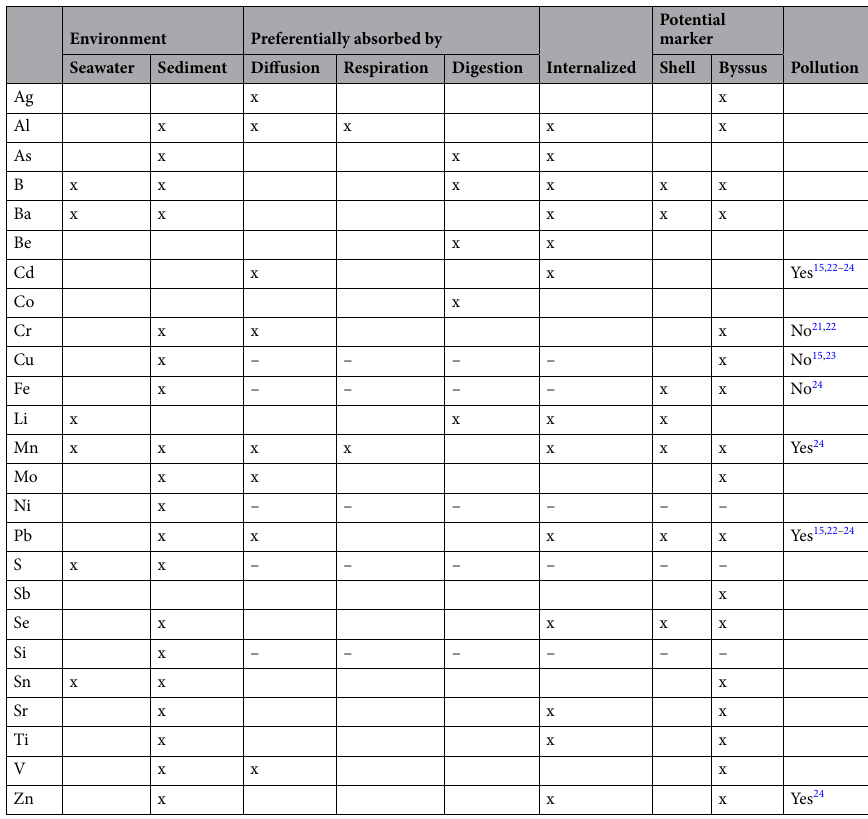
Table 2. Summary of the observations on the possible preferential absorption route, eventual internalization, and potential use of external matrices as marker of the metal past-exposure/presence in the organism. When (–) was used the physiological role, or the highly presence in the environment of the element, did not allow an interpretation of the results. Pollution status was defined based on previous data in literature, when